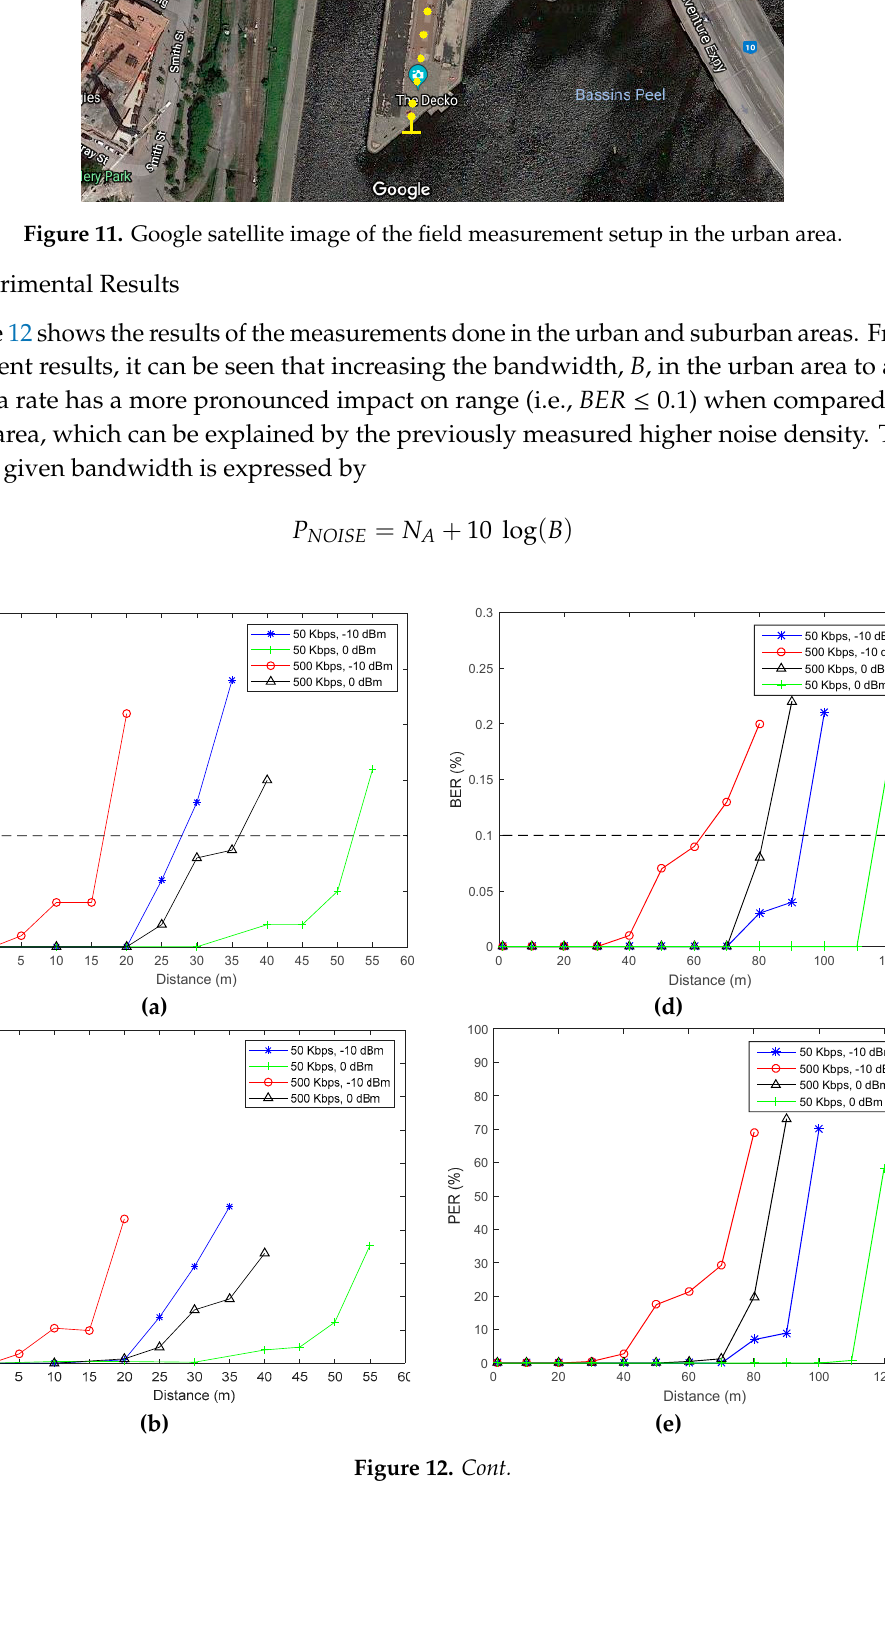
(f) Figure 12. BER, PER, and RSSI field measurements in ( a – c ) the urban and ( d – f ) the suburban areas. It was previously mentioned that using high data rates would result in a better energy consumption, as depicted in Figure 6. However, the achievable communication range was yet unknown. Figure 12 shows that, at 0.1% BER as required by Bluetooth applications, similar communication ranges can be achieved by increasing the output power and data rate (i.e., 500 Kbps and 0 dBm) or decreasing them (i.e., 50 kbps and − 10 dBm). However, Figure 6 shows that the energy